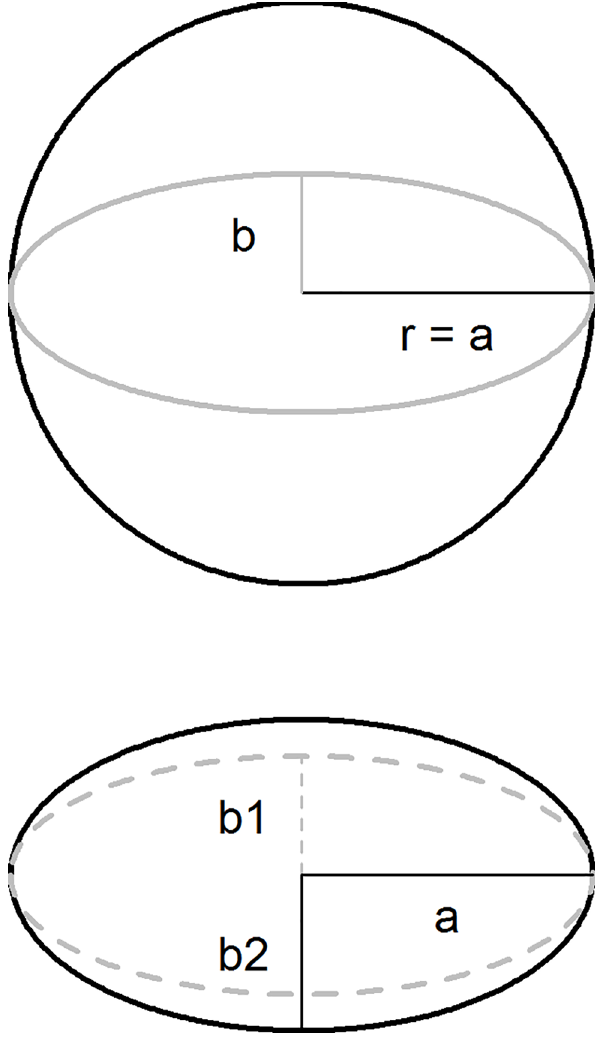
as A = pi * a * b where a is ½ the length of the major axis and b is ½ the length of the minor axis. B) Example of overall area of ellipse calculated using the ratio of major to minor axes (dashed ellipse = 2.4 the average ratio for polyethylene nets (b1 = half the length of the minor axis), solid ellipse = 1.9 the average ratio for polyester nets (b2 = half the length minor axis). Polyester nets: 100 denier, traverse [3.5.50], Polyethylene nets: 150 denier, tulle